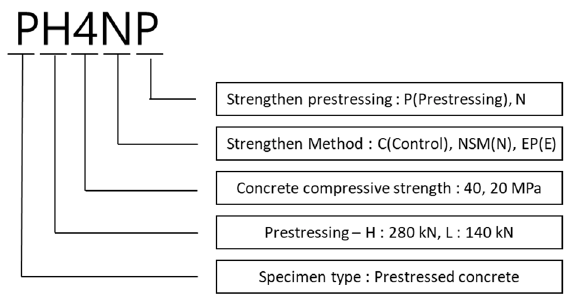
Figure 2. Explanation for the nomenclature of specimen codes.